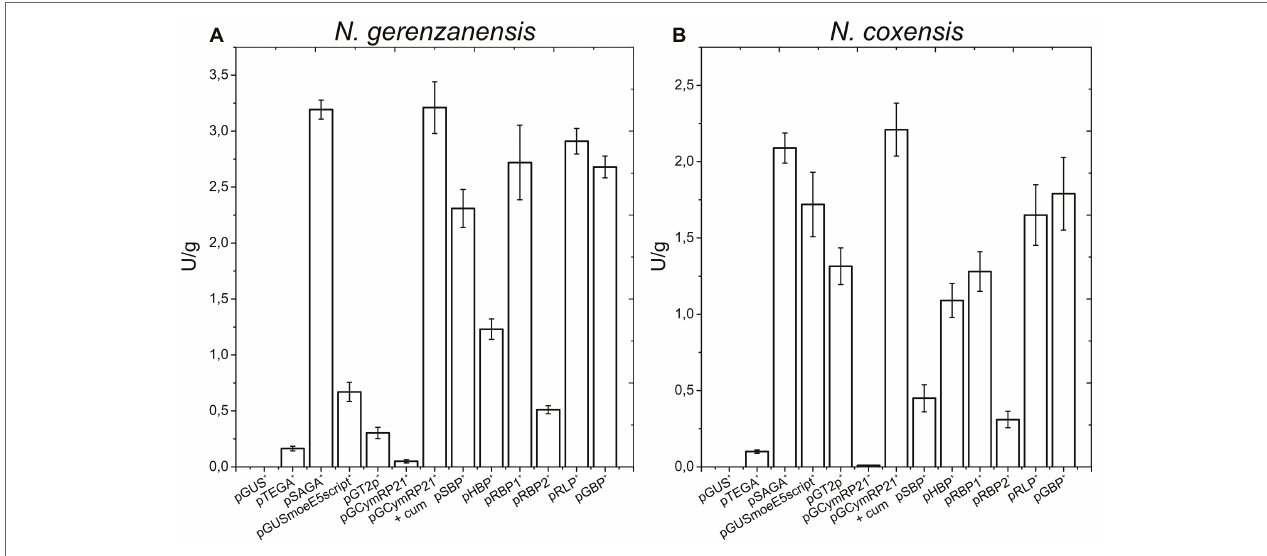
FIGURE 2 | Quantitative measurement of GusA activity (U/gram of dry biomass) in N. gerenzanensis (A) and N. coxensis (B) recombinant strains grown in liquid media for 120 h (see growth curves in ESM Figure 5 ), carrying different promoter-probe plasmids. Control strains carried the promoterless pGUS vector and exhibited no GusA activity. Activities are the mean values of three independent experiments. Error bars represent standard deviations.